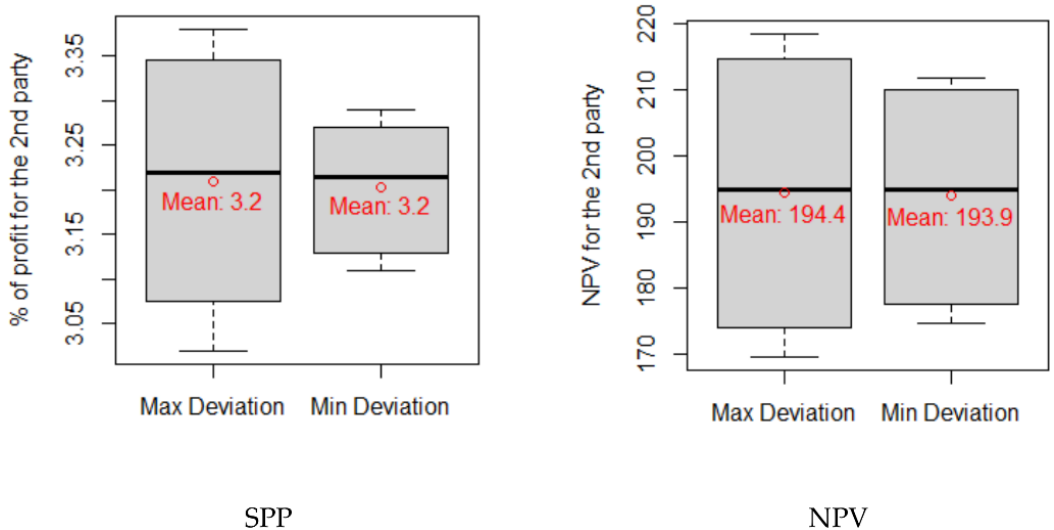
Figure 9. The variability in the best and worst runs in the chosen sample (3.21% for SPP).